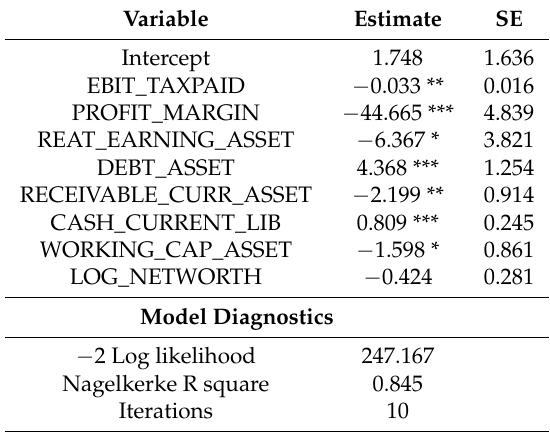
Table 3. Logistic estimation